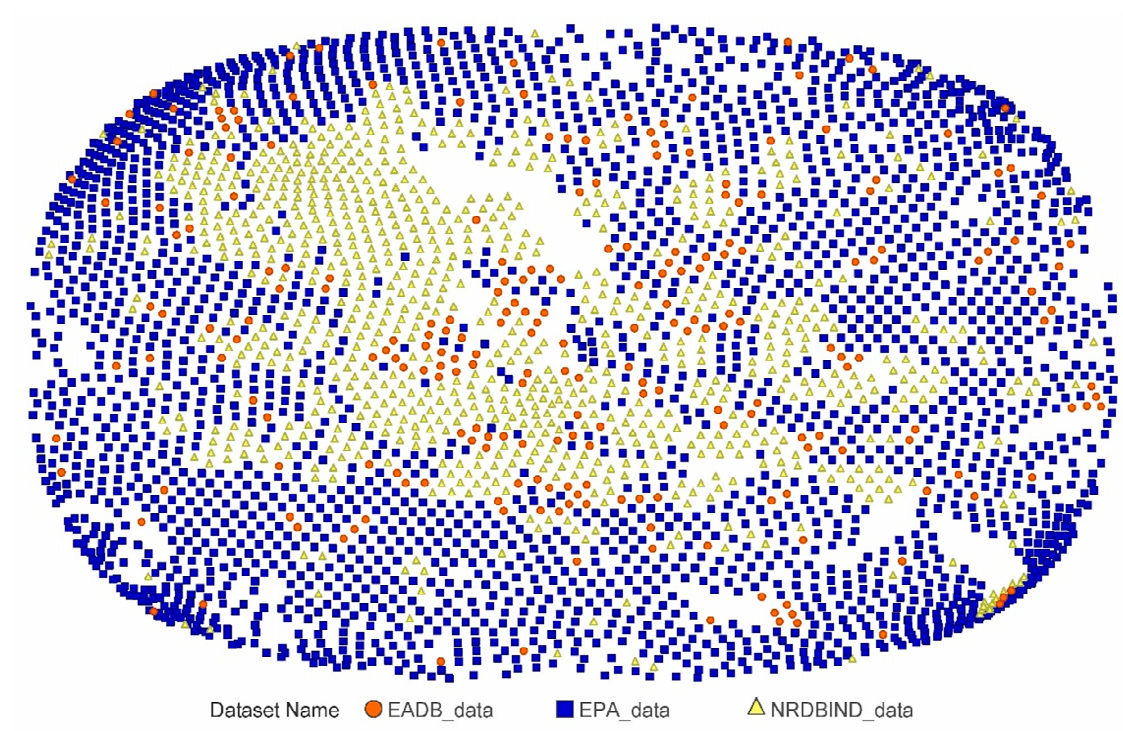
Figure 2. Structure Activity Landscape Index (SALI) maps for all three databases (B and NB compounds): Environmental Protection Agency (EPA) (blue), Nuclear Receptors DataBase Including Negative Data (NR-DBIND) (yellow) and Estrogenic Activity DataBase (EADB) (orange).